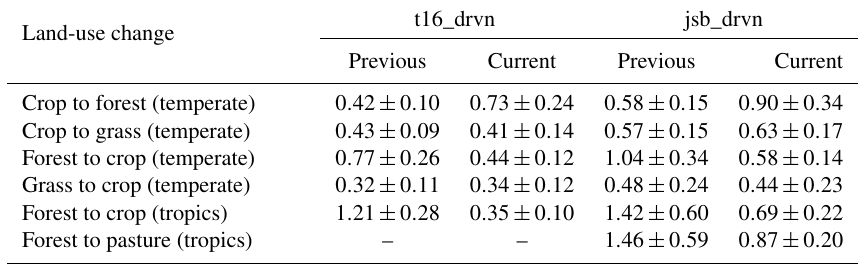
Table 5. Mean annual equilibrium litter fluxes in kgCm − 2 for previous and current land use in the different LUCs and simulations ( ± SD). t16_drvn jsb_drvn jsb_drvn_harv Land-use change Previous Current Previous Current Previous Current Crop to forest (temperate)